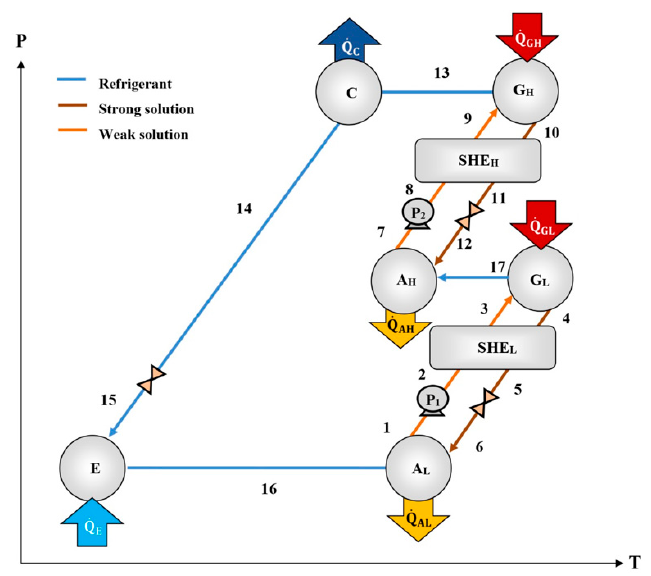
Figure 2. Pressure–Temperature diagram for a half-effect absorption cooling system.